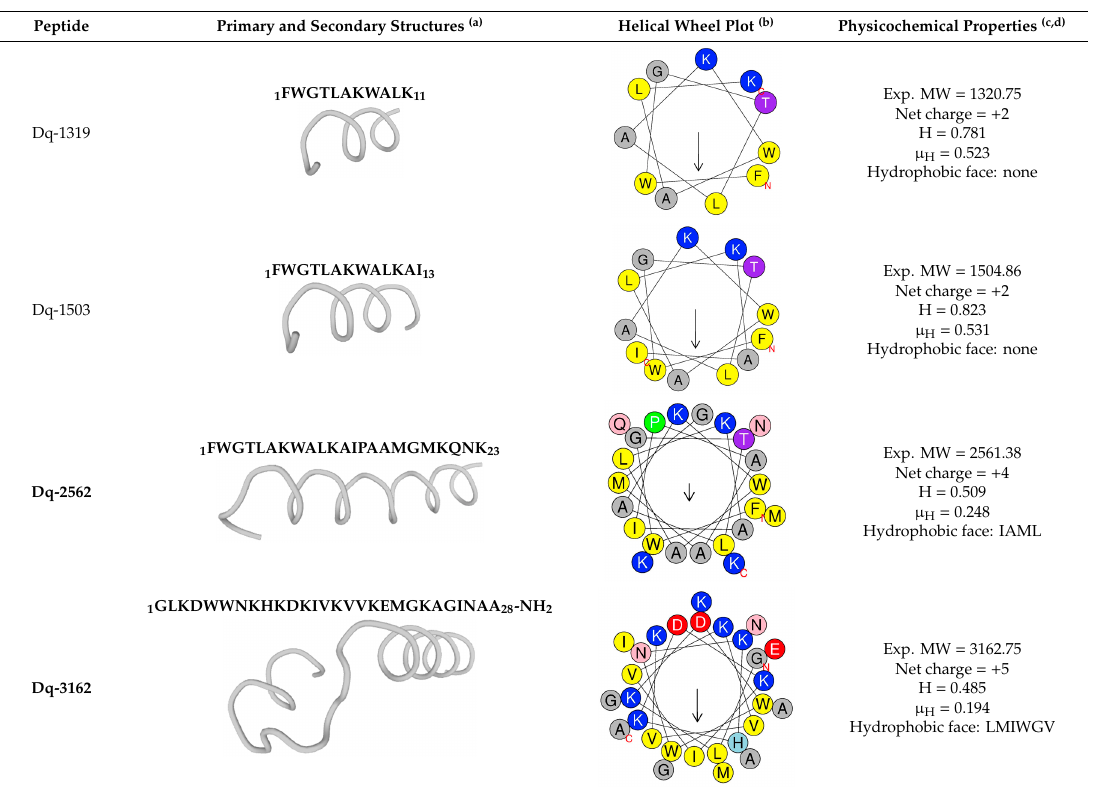
Table 1. Structures, predict models and physicochemical characteristics of synthetic pilosulin- (Dq-2562, Dq-1503, and Dq-1319) and ponericin-like (Dq-3162) peptides from the venom of giant ant Dinoponera quadriceps